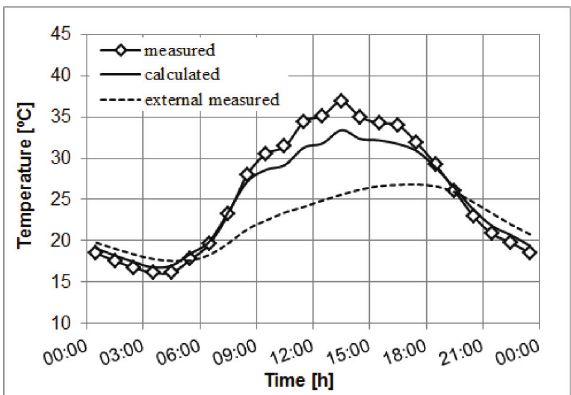
airFig. 6b. average hourly temperatures of external surface of thermal insulation layer and external air